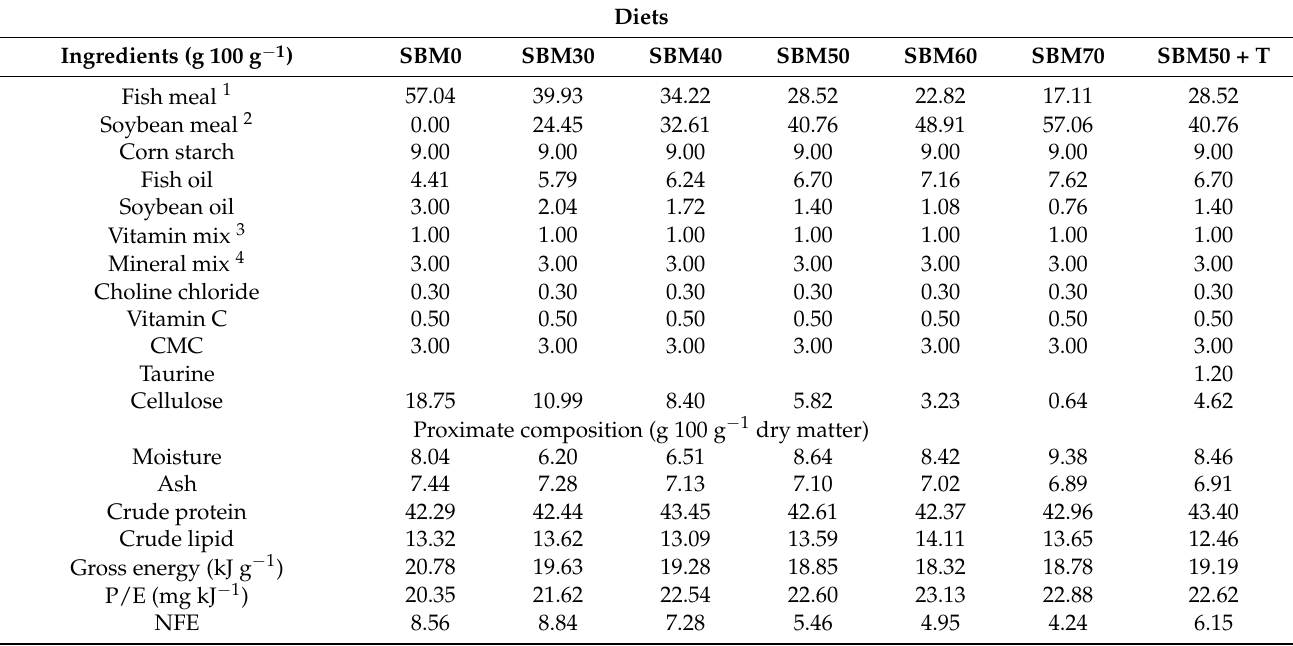
Table 1. The formulation and proximate composition of the experimental diets (% dry matter). Diets